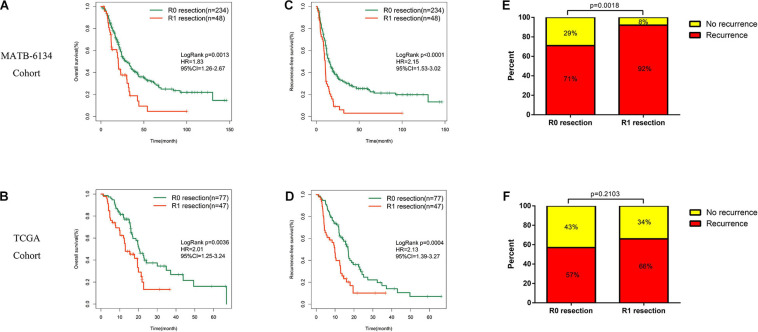
Survival difference between R0 and R1 treated patients. (A,B) K-M curves estimate OS difference between R0 and R1 margin. (C,D) K-M curves of RFS between patients with R0 and R1 resection. (E,F) Relationship of resection margin status and recurrence rate.